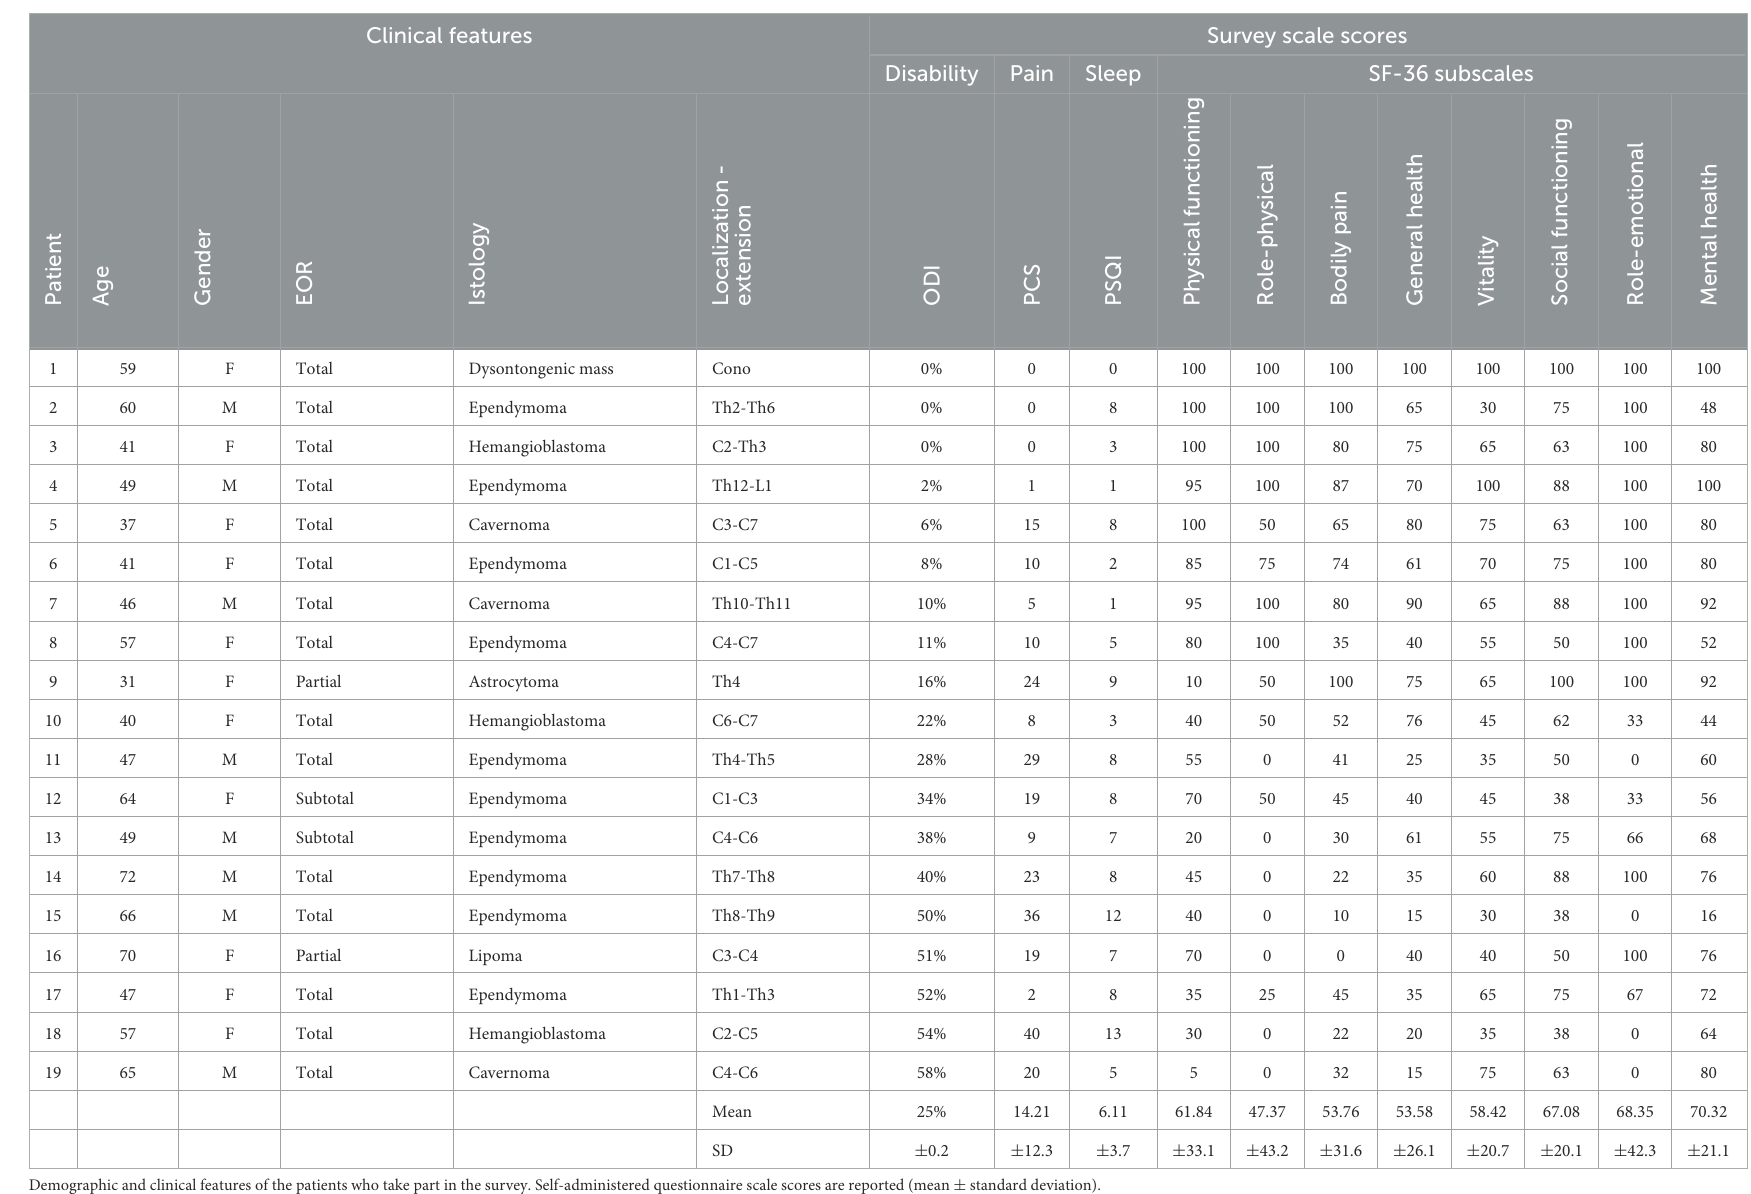
TABLE 1 Demographic and clinical